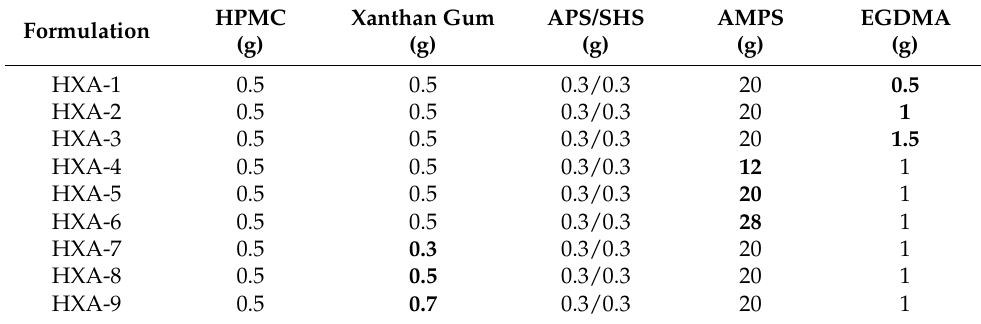
Table 1. The composition of fabricated xanthan gum-based (HPMC- g -AMPS) hydrogels. Formulation